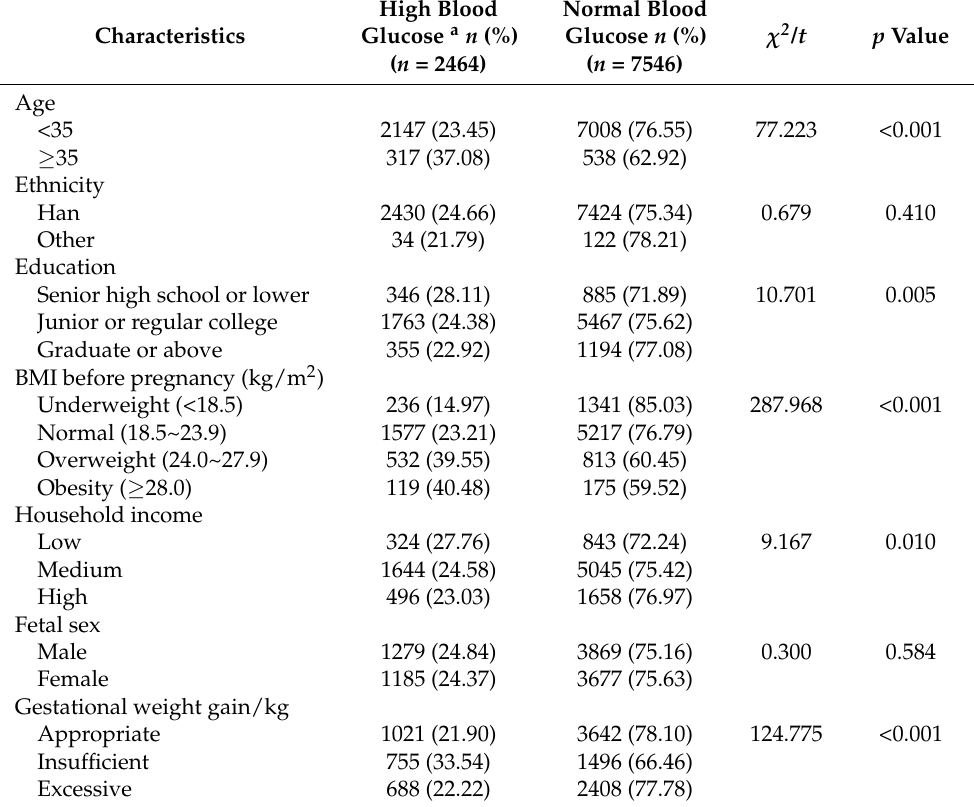
Table 1. General characteristics of study subjects ( n =